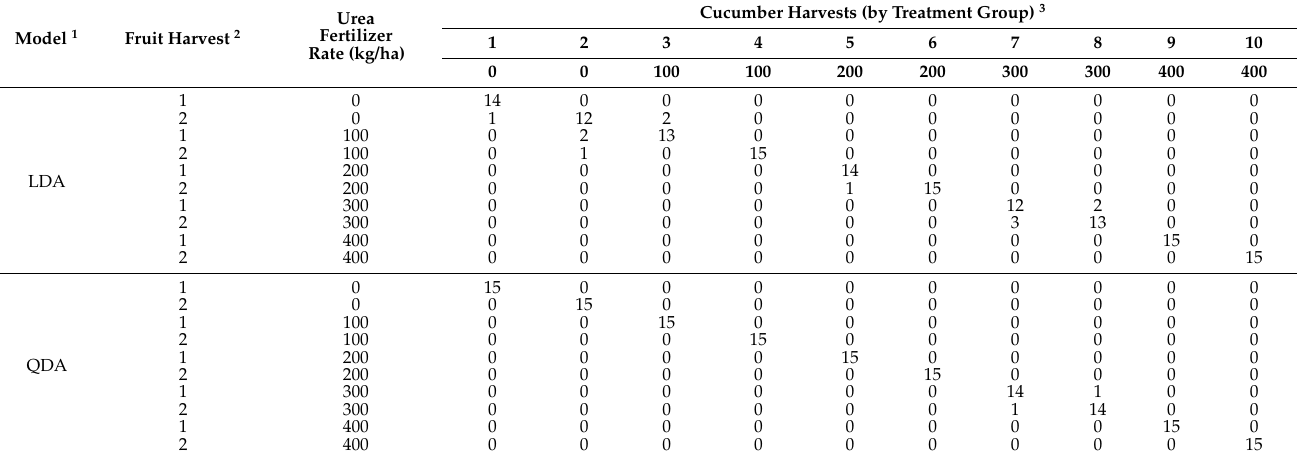
Table 2. Confusion matrix for the 2-group classification of 10 treatment groups of harvested cucum- bers (based on the amount of urea fertilizer applied) using the LDA and QDA statistical